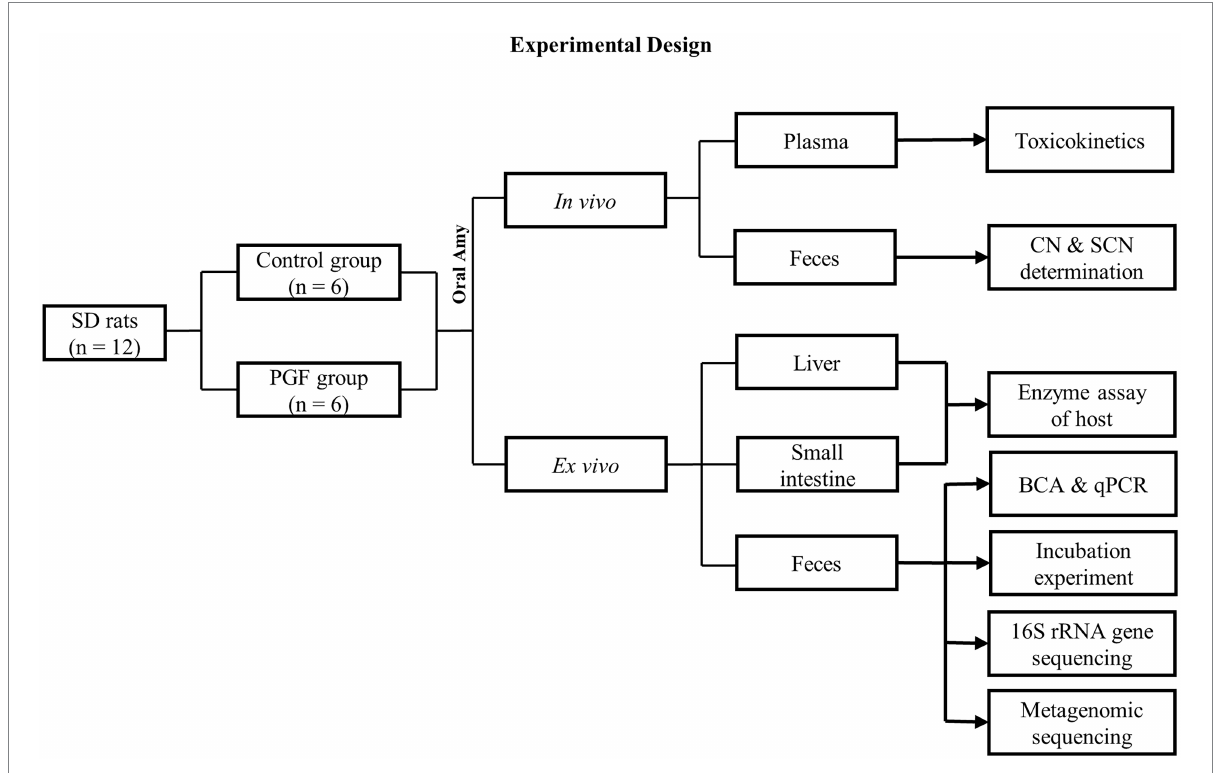
FIGURE 1 Flow diagram of the Experimental